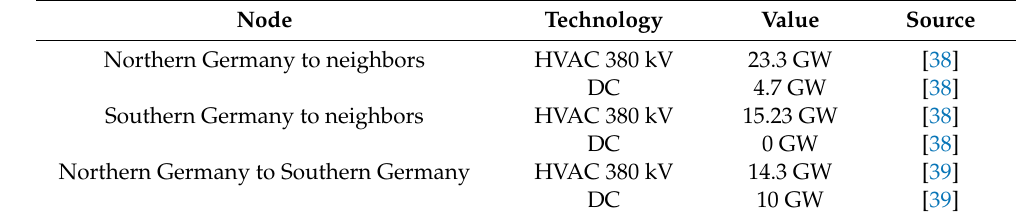
Table A4. Net transfer capacities from and to